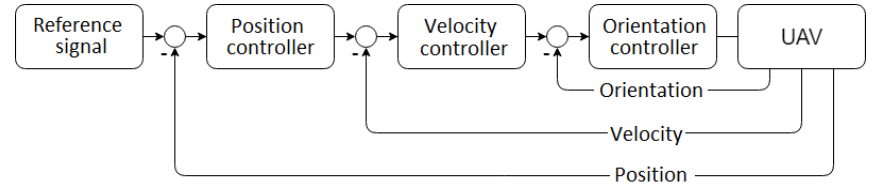
Figure 5. Typical cascade of controllers in